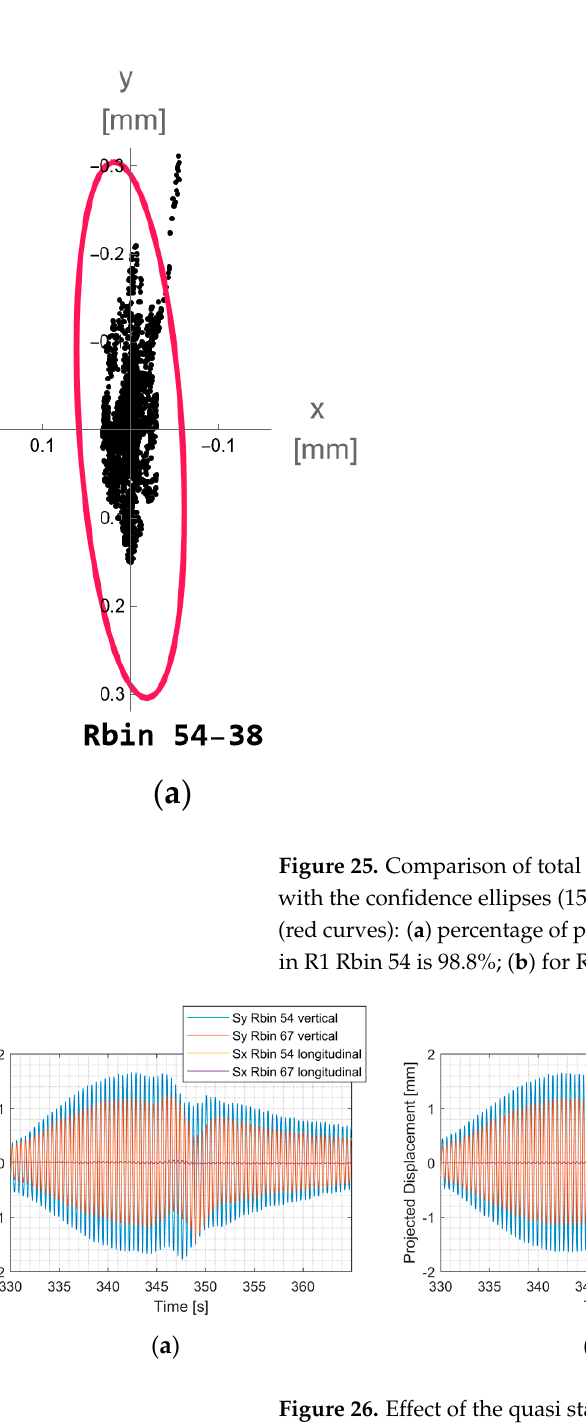
Figure 26. Effect of the quasi static components on the total displacement. Longitudinal and vertical displacements caused by the regular pace of a group of pedestrians during concurrent passage of a vehicle across the bridge: ( a ) including the quasi static component calculated by combination of both radar measurements. The irregularity of the oscillation is caused by the vehicle crossing the bridge at the same time; ( b ) without the quasi static component calculated by combination of both radar measurements. ( c ) Corresponding longitudinal and vertical displacements converted from accel- erometers measurement.